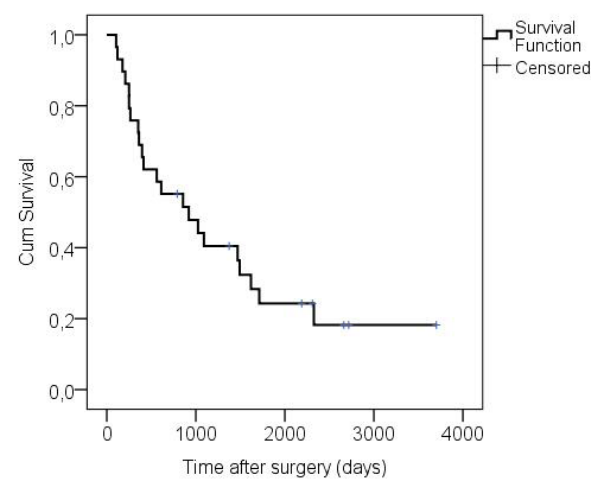
Fig. 1. Overall survival of all patients after resection for distal cholangiocarcinoma estimated using the Kaplan-Meier analysis.